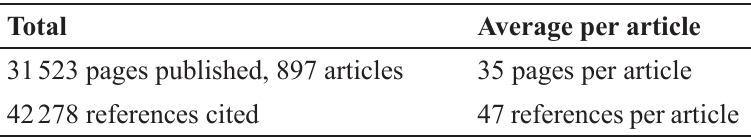
Table 1. FileMaker dataset showing the average number of references cited within EJT articles.